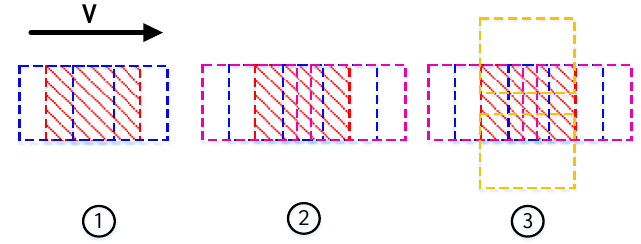
Figure 7. Three kinds of matching configurations for multi-view dense matching based on a graph network: ① considers only adjacent image pairs in flight ② considers all possible image pairs with overlap, in flight ③ considers overlapping image pairs both in flight and across flights.